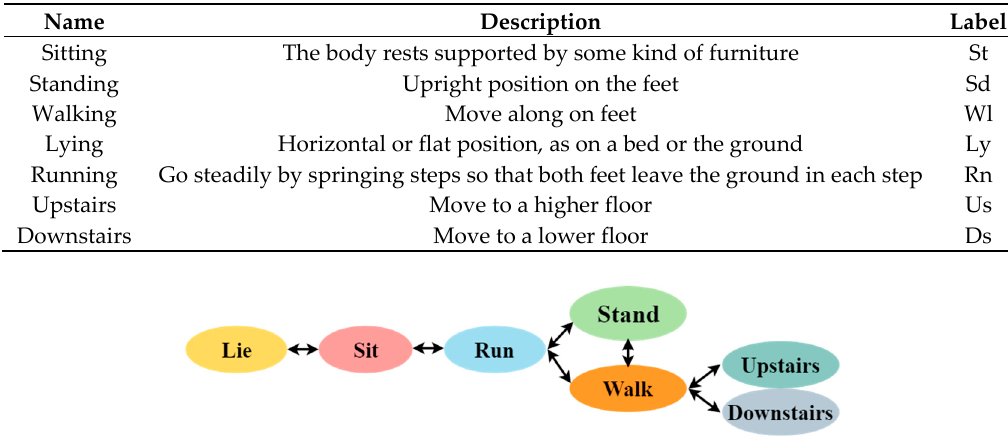
Figure 1. Transition states